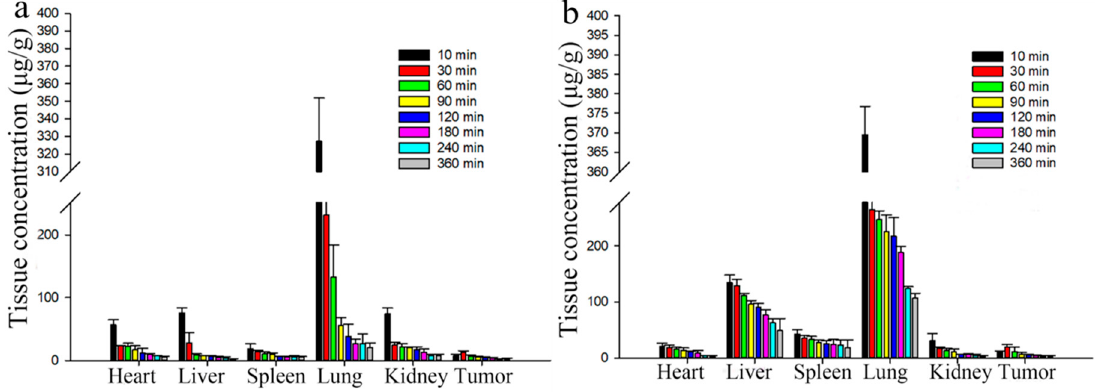
Figure 13. Concentration of DTX in different tissues at different time following via the tail vein dose (25 mg/kg) of Duopafei ® ( a ) and DTX-loaded BSPs-SA nanoparticles ( b ). Data are shown as mean ± SD. ( n = 5).